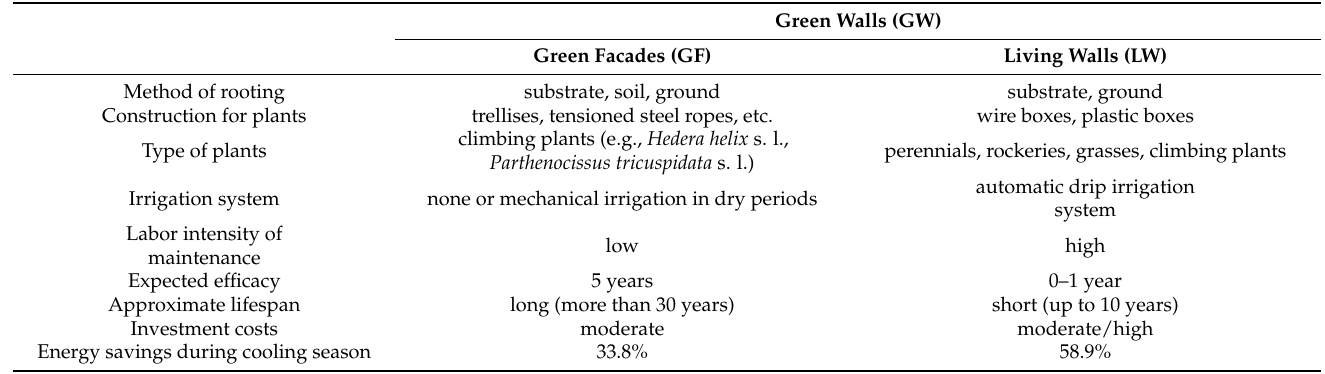
Table 1. An overview of the differences between green facades and living walls